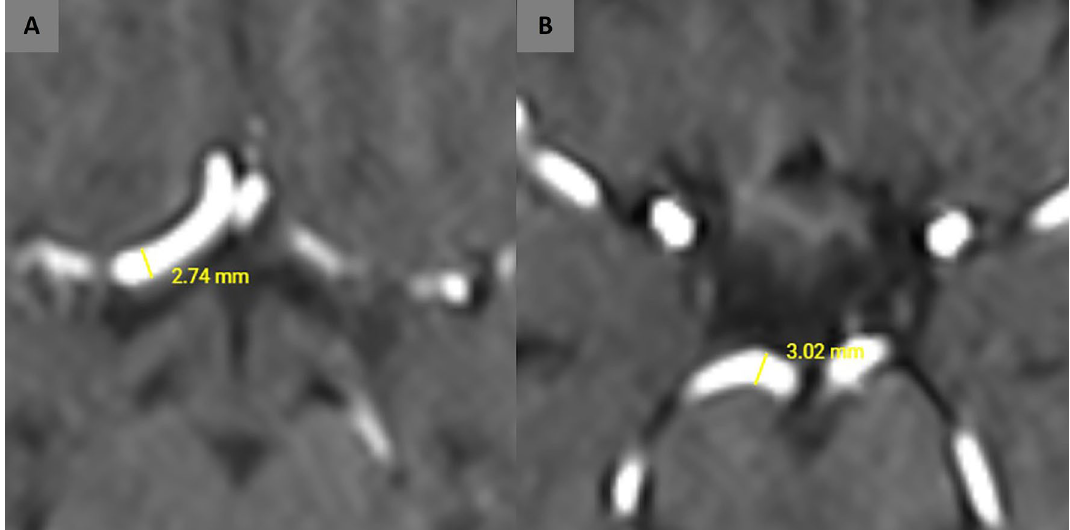
Figure 2. The measurements of vascular diameters of the right A1 segment ( A ) and right P1 segment ( B ) were shown. Axial MR images with ×400 magnification were used to measure the vessel calibers.